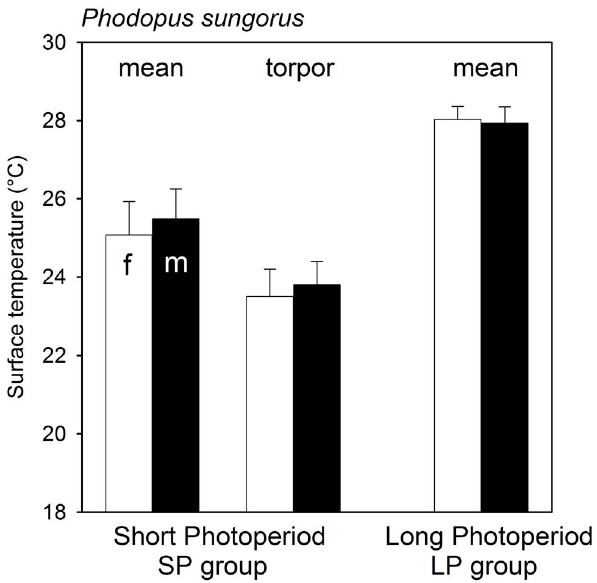
Figure 1. Mean surface temperatures ( ± 1SD) female (f) and male (m) Phodopus sungorus acclimated to short and long photoperiods and maintained at T a 18 6 C. Values for torpid individuals are shown only for the short photoperiod group because none of the long photoperiod animals displayed torpor.